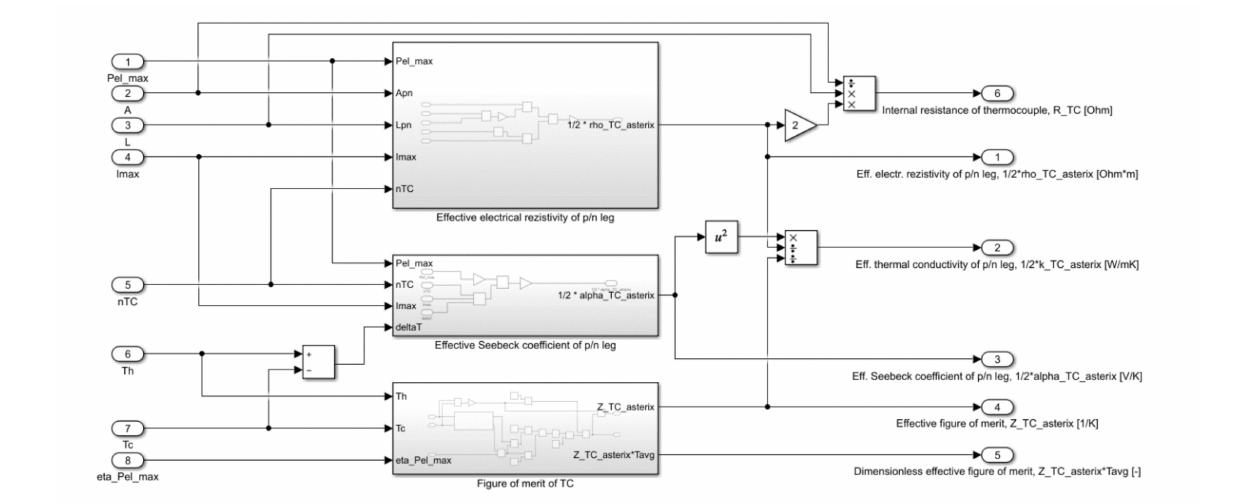
Figure A14. Effective properties model blocks (Figure 3)—Detail of the effective material properties block (Figure